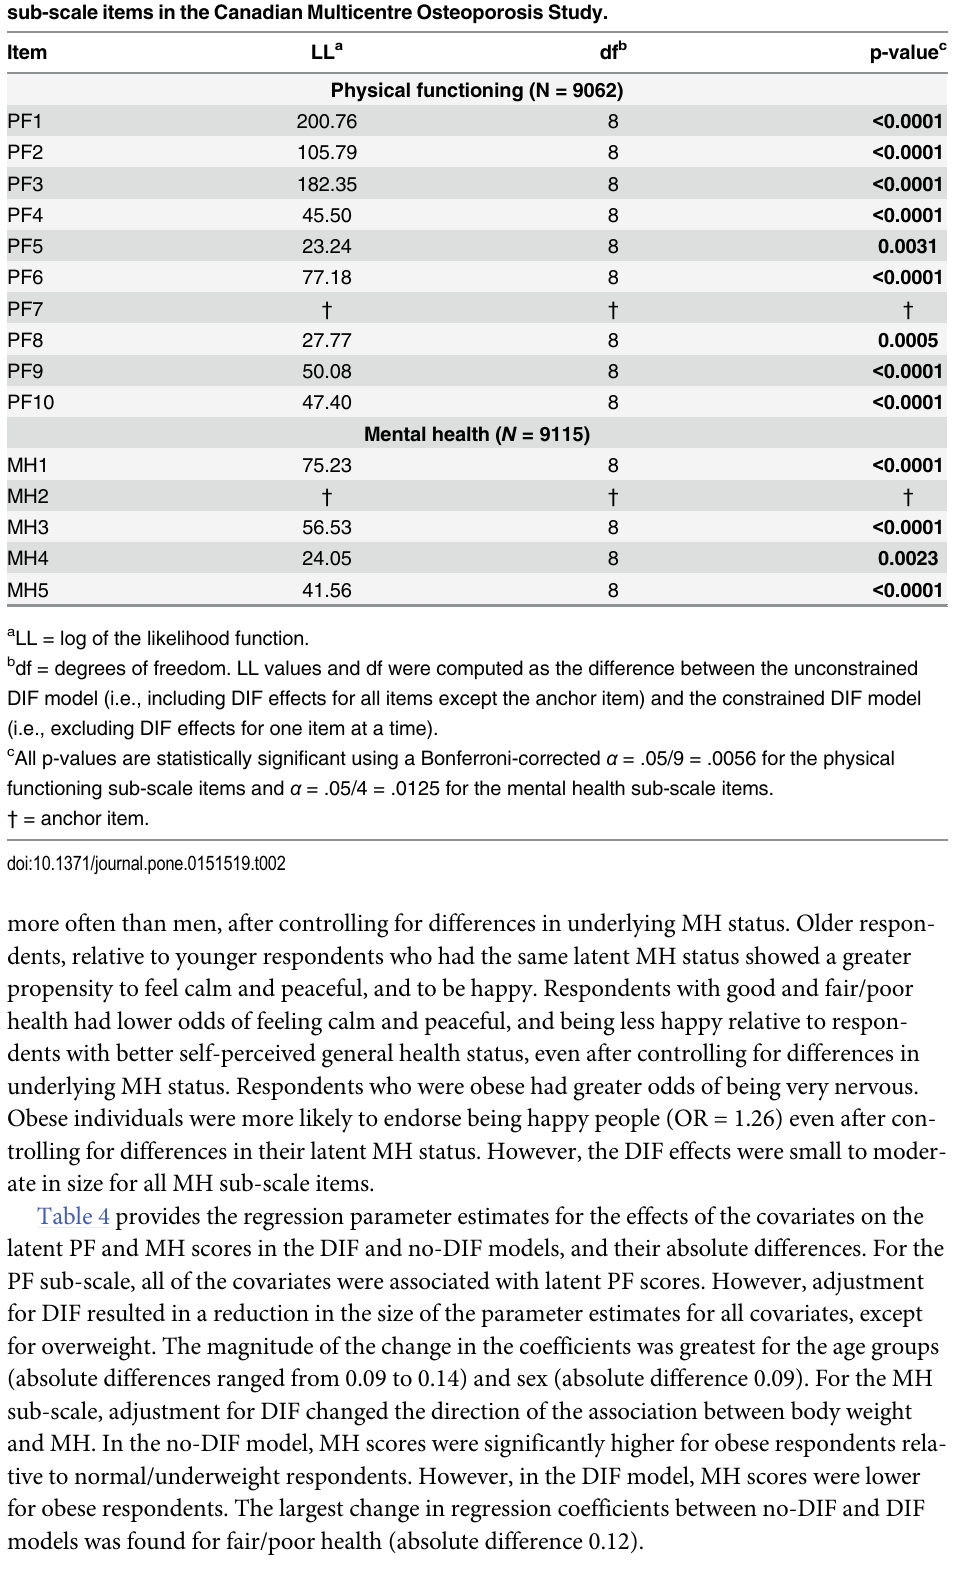
latent PF and MH scores in the DIF and no-DIF models, and their absolute differences. For the PF sub-scale, all of the covariates were associated with latent PF scores. However, adjustment for DIF resulted in a reduction in the size of the parameter estimates for all covariates, except for overweight. The magnitude of the change in the coefficients was greatest for the age groups (absolute differences ranged from 0.09 to 0.14) and sex (absolute difference 0.09). For the MH sub-scale, adjustment for DIF changed the direction of the association between body weight and MH. In the no-DIF model, MH scores were significantly higher for obese respondents rela- tive to normal/underweight respondents. However, in the DIF model, MH scores were lower for obese respondents. The largest change in regression coefficients between no-DIF and DIF models was found for fair/poor health (absolute difference 0.12).